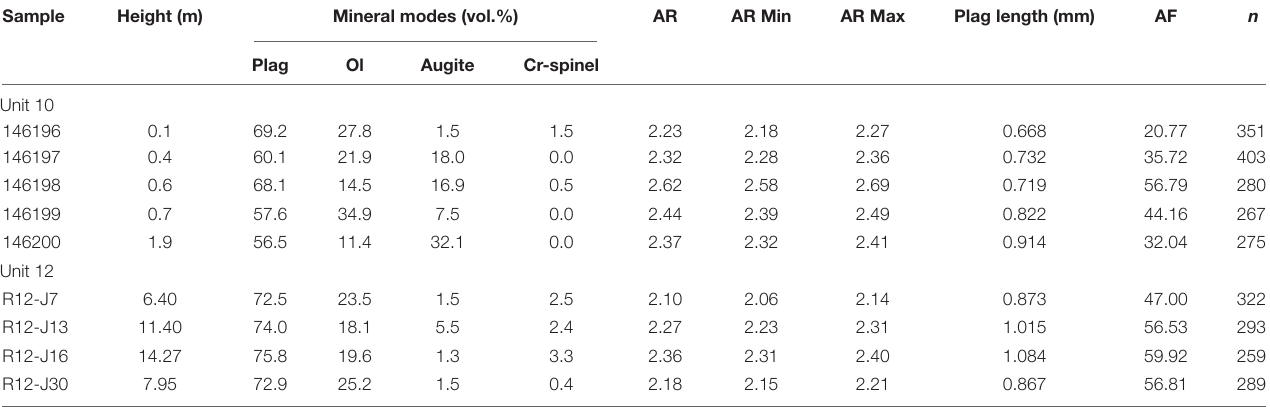
Abbreviations as for Table 1 .